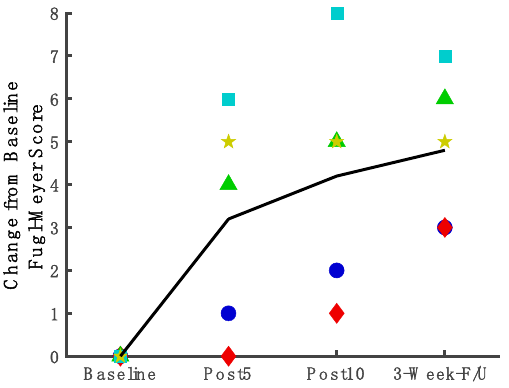
Figure 4. Trajectories of improvement in motor impairment measures throughout the study duration.